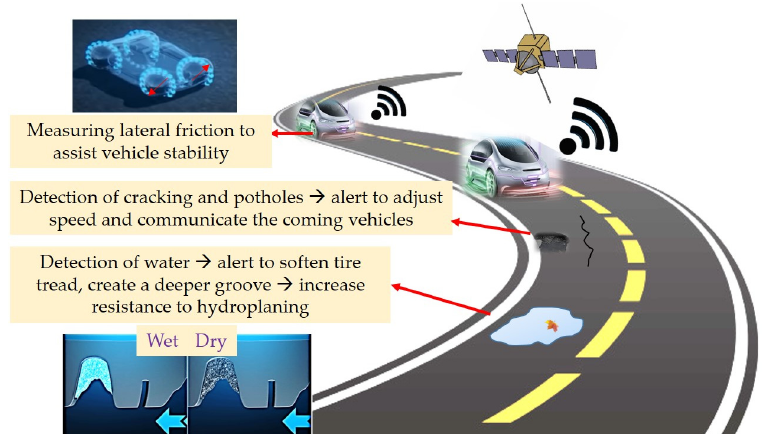
Figure 14. Potential benefits from vehicle mobility patterns with connected tires (adapted by [98]), case of an interurban road environment.